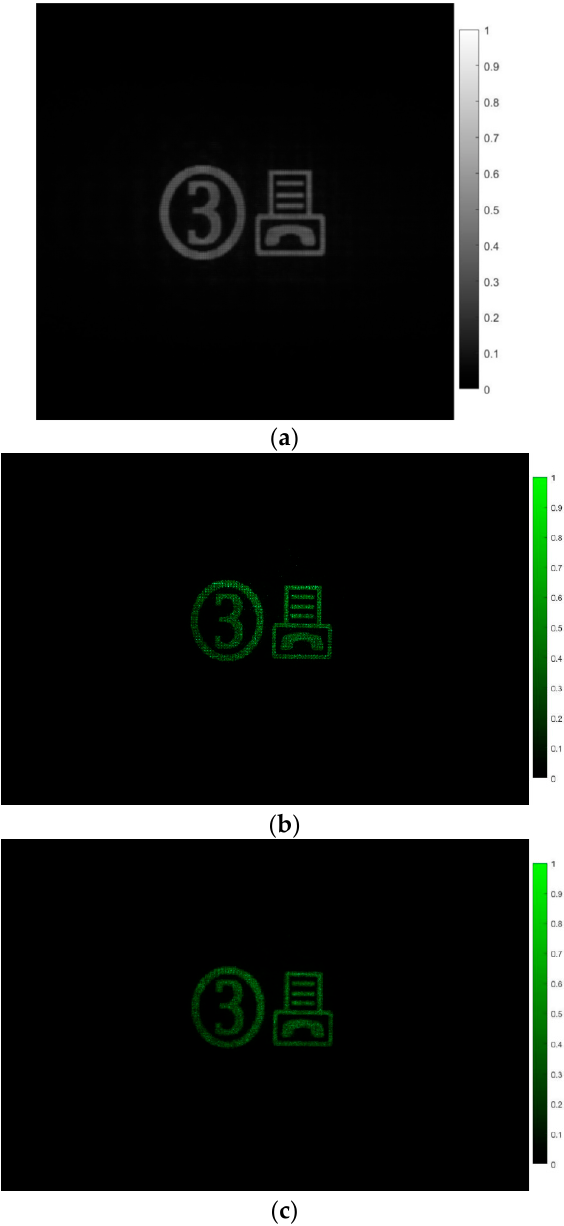
Figure 7. ( a ) Numerical reconstructed of the SPOH of the source image, based on down-sampling factor τ = 16, in Figure 1a after applying TDCF, ( b ) optical reconstructed image of the SPOH, ( c ) optical reconstructed image of the SPOH after applying TDCF.